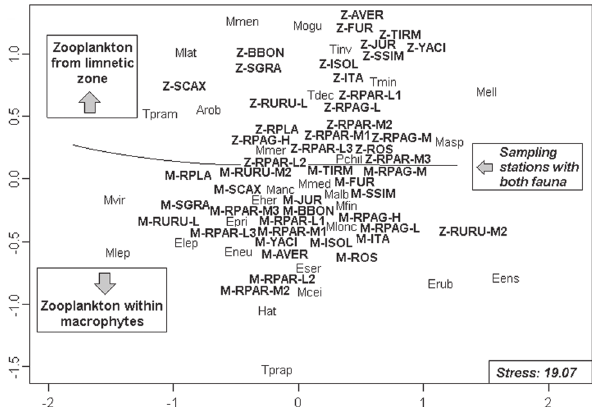
Figure 3. NMDS analysis for ordination of sampling stations and cyclopoid species in our study. See three groups of sampling sites and species: zooplankton, macrophytes and a median group where species occurred were found in zooplankton and macrophytes. For codes of species see Table